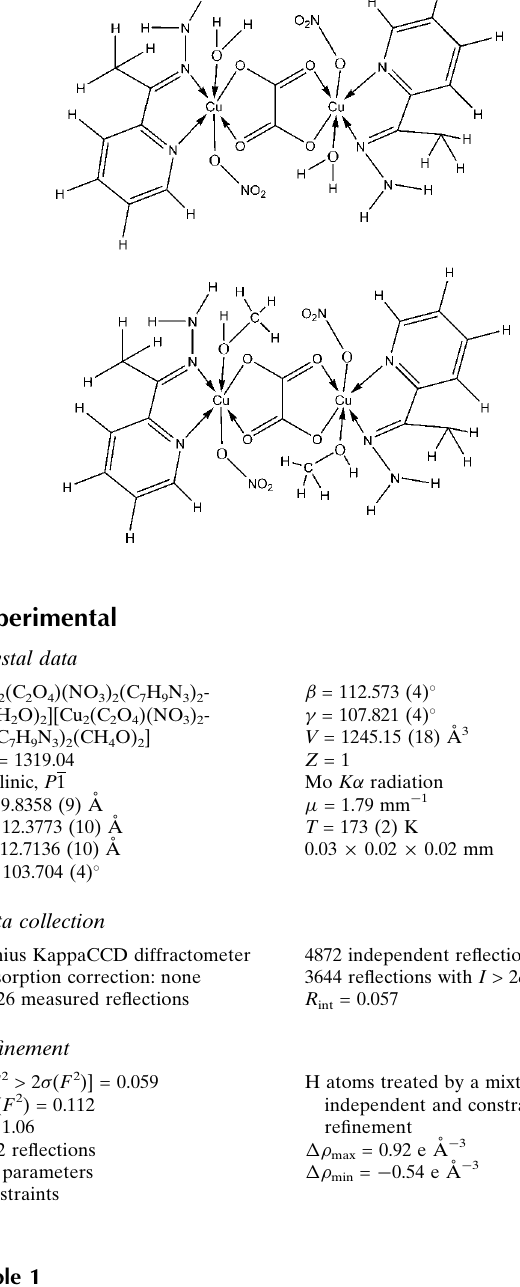
Selected bond lengths (A˚